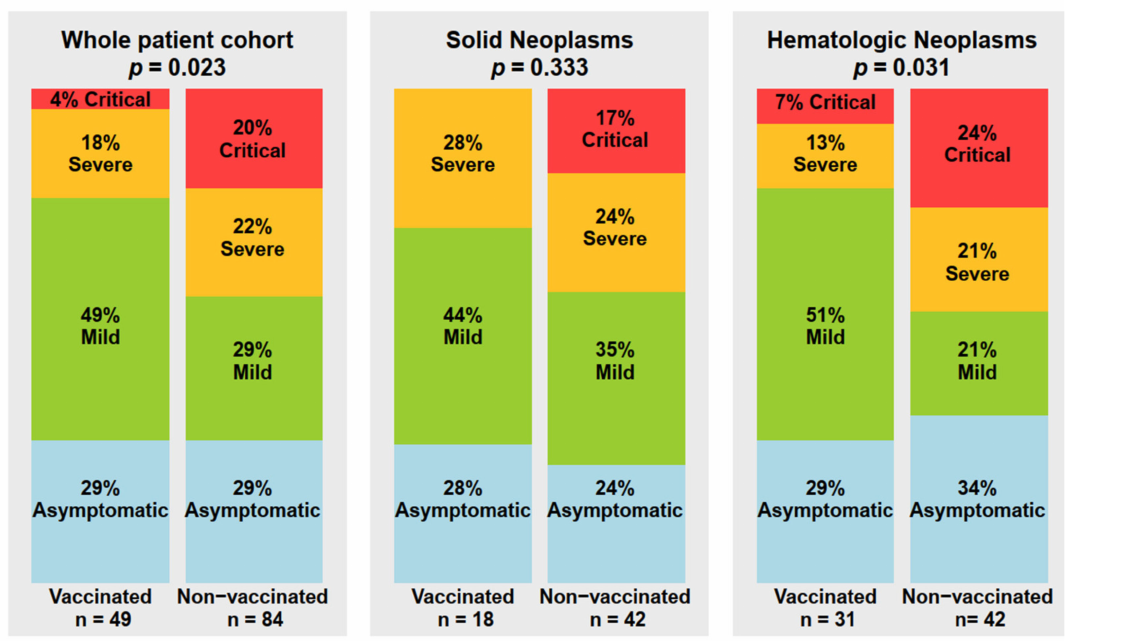
Figure 2. Severity of SARS-CoV-2 infection in non- and vaccinated cancer patients of the study. The course of the COVID-19 infection differed significantly between the vaccinated and non-vaccinated groups, with significantly more patients developing mild and significantly fewer having a severe or critical course in the vaccinated group (Table 3 and Figure 2). In detail, 29% ( n = 24/84) and 49% ( n = 24/49) had a mild, 22% ( n = 19/84) and 18% a severe ( n = 9/49), and 20% ( n = 17/84) and 4% ( n = 2/49) a critical course among non-vaccinated and vaccinated patients, accordingly ( p =